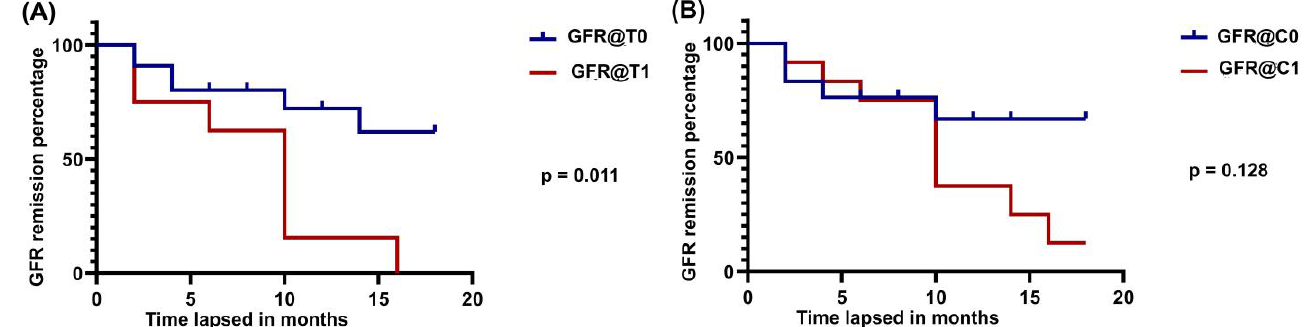
Figure 4. GFR remission in IgA nephropathy. ( A ): GFR remission curve in follow-up to 18 months with respect to the conditions against T0 and T1. GFR@T0 — GFR remission in T0 stage. GFR@T1 —